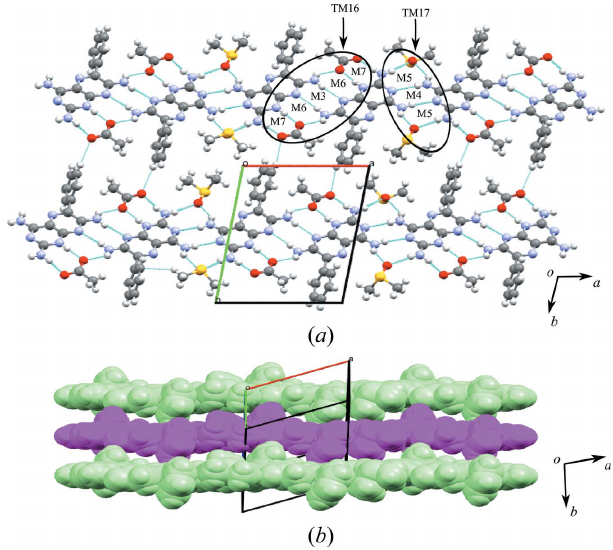
Figure 4 ( a ) Motifs M7, M6, M3, M6 and M7 (TM16), and M5, M4 and M5 (TM17) found in the crystal structure of 1a (cid:3) DMSO. ( b ) The host–guest network in the form of stepped tapes forming a sheet structure.